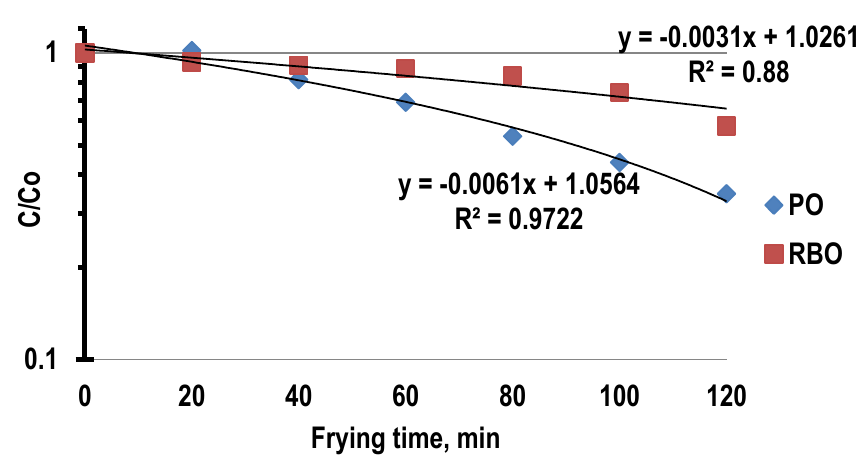
Figure 6. First order kinetic plots of the degradation of γ-tocotrienol in palm oil and rice bran oil during deep-frying.